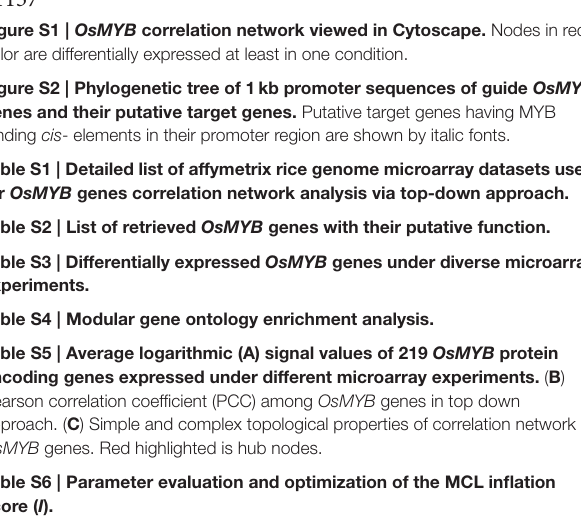
Figure S1 | OsMYB correlation network viewed in Cytoscape. Nodes in red color are differentially expressed at least in one condition. Figure S2 | Phylogenetic tree of 1kb promoter sequences of guide OsMYB genes and their putative target genes. Putative target genes having MYB binding cis - elements in their promoter region are shown by italic fonts.